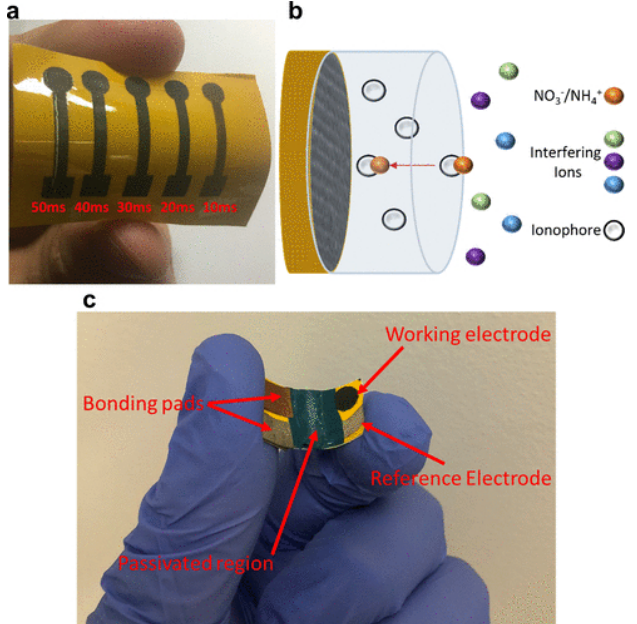
Figure 7. ( a ) Photograph of five LIG SC ISEs on a single polyimide swatch. ( b ) Illustration of SC-ISE ion sensing. ( c ) Representative electrode used in soil column studies. Passivated regions are shown as well as bonding pads, working electrode, and reference electrode. [Reprinted with permission from ref.